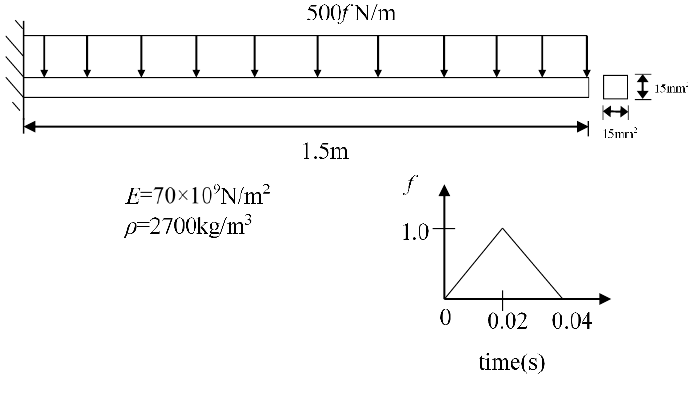
Figure 19. Cantilever beam model.